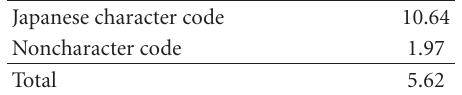
Table 4: Mean number of erroneous node per segment.